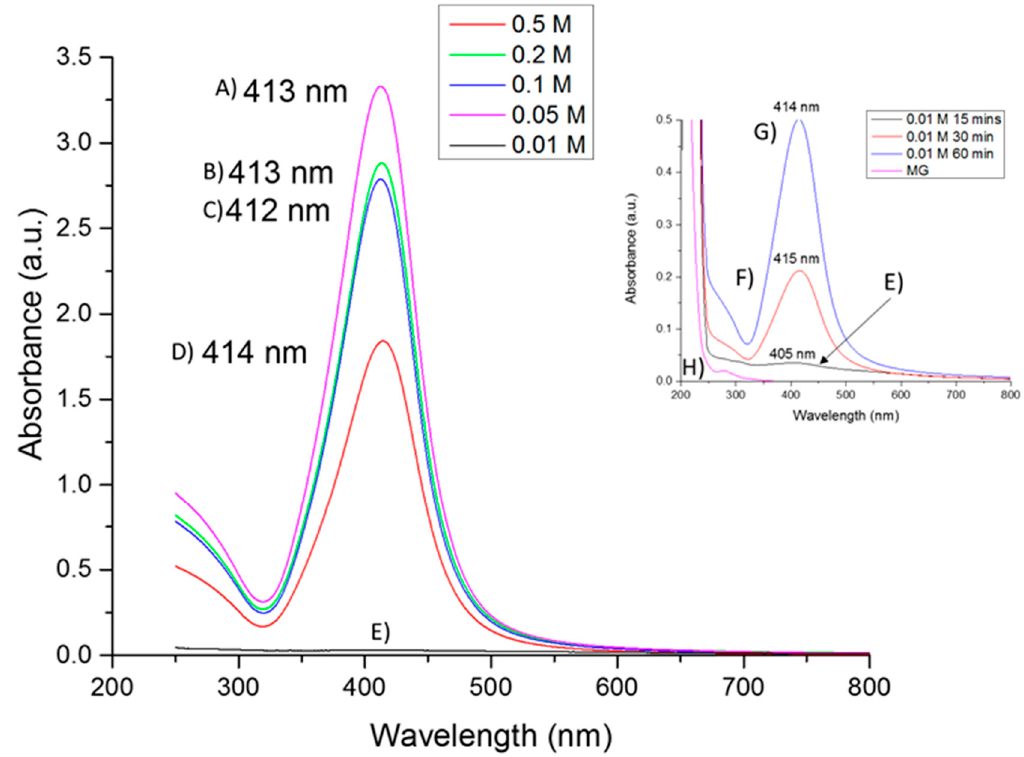
Figure 1. UV ‐ VIS absorption spectra of silver nanoparticles with different initial AgNO 3 Figure 1. UV-VIS absorption spectra of silver nanoparticles with different initial AgNO